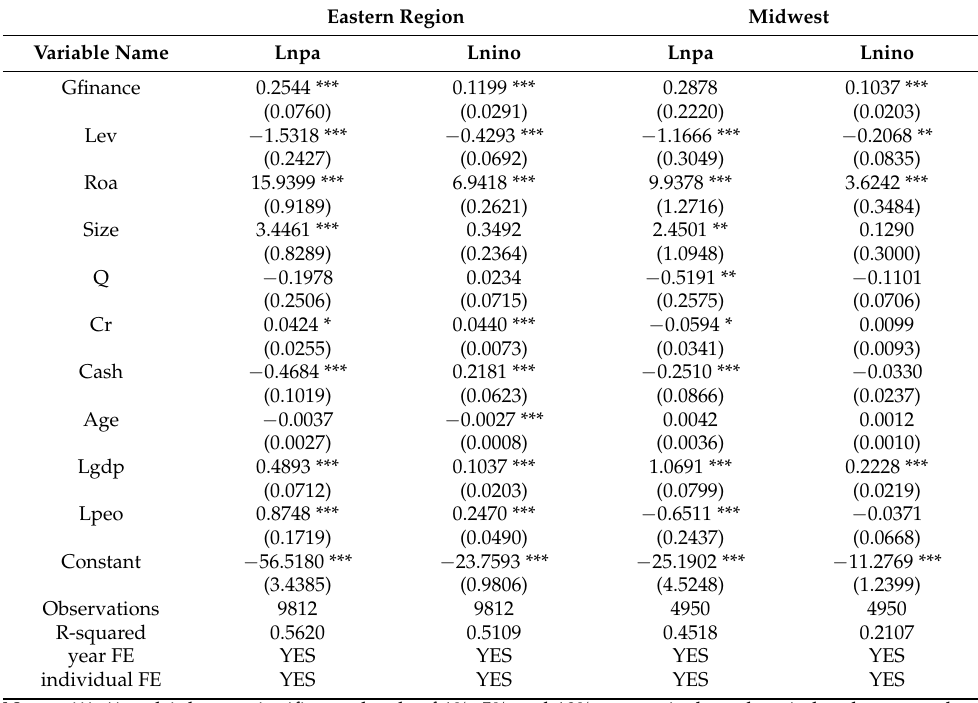
Table 9. Test for heterogeneity of test area